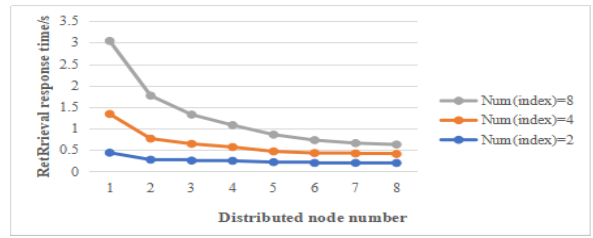
Figure 9. Comparison of distributed multi-keyword retrieval efficiency under different node number